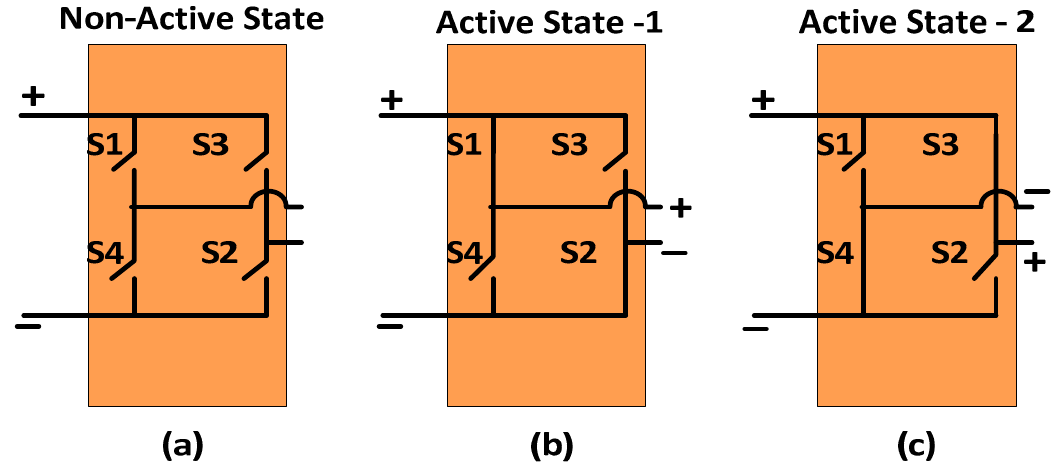
Figure 5. Non-active and active states: ( a ) non-active state, ( b ) active state-1, and ( c ) active state-2.